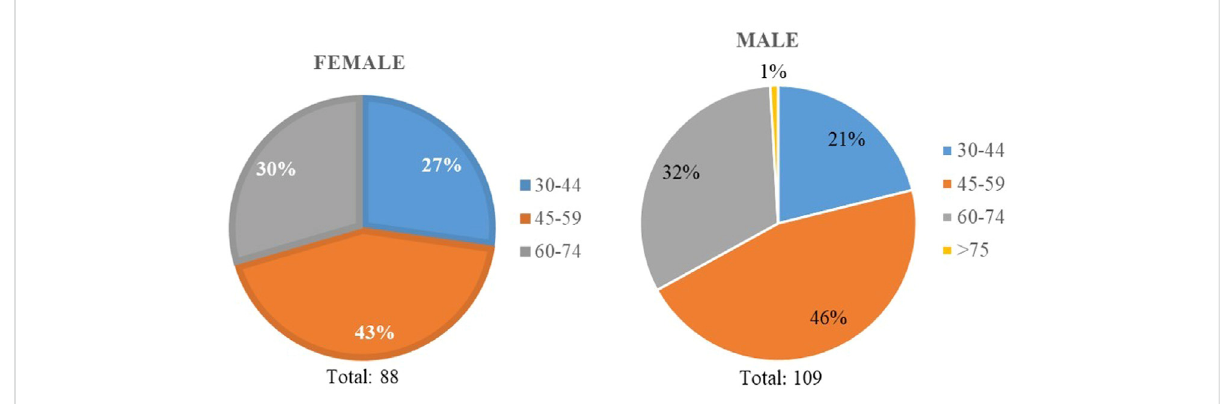
FIGURE 4 Age groups of informants.